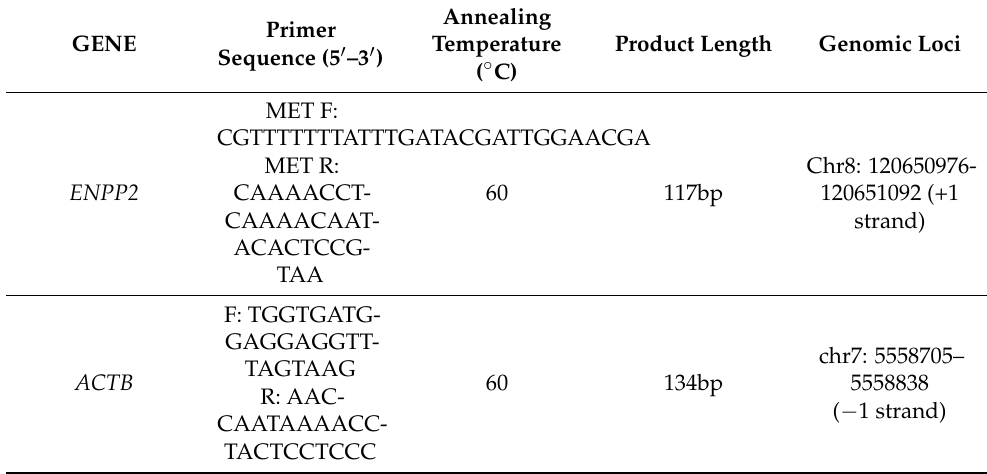
Table 8. Primer sequences, annealing temperatures, and genomic locations used for qMSP